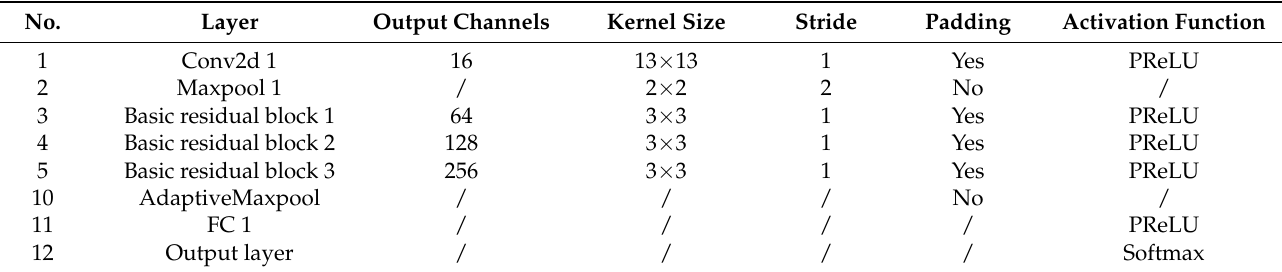
Table 2. Hyperparameters of the proposed